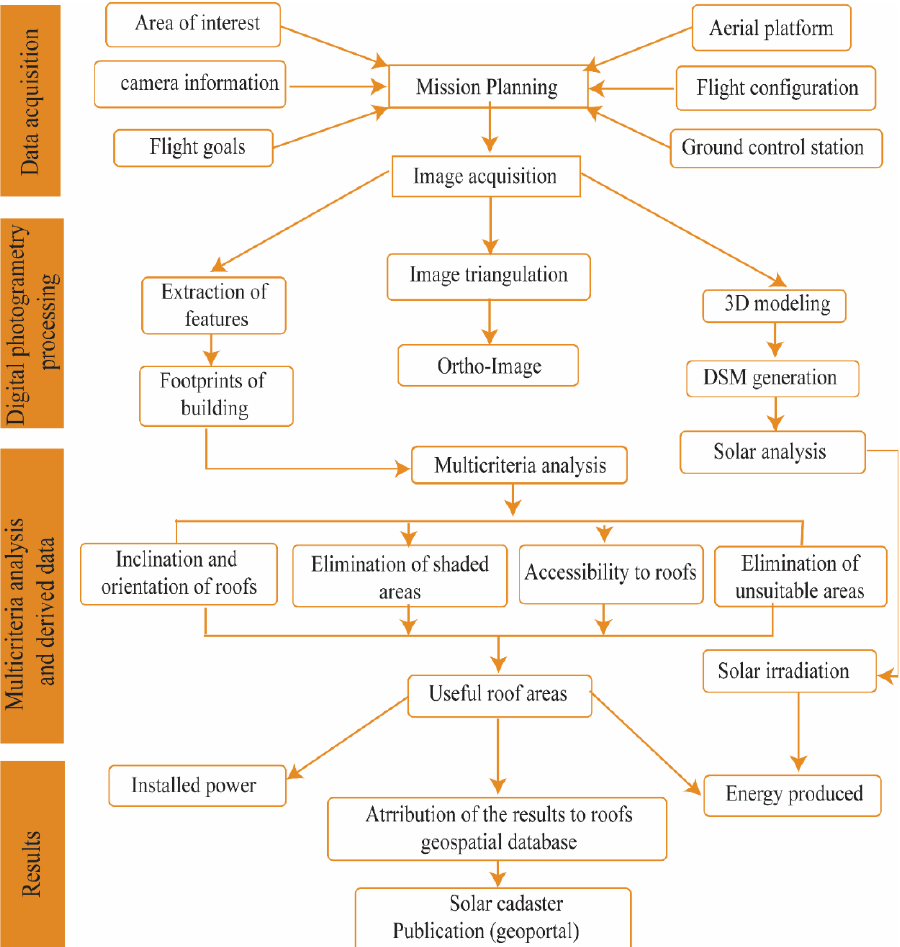
Figure 2. Descriptive flowchart of operations for establishing a solar